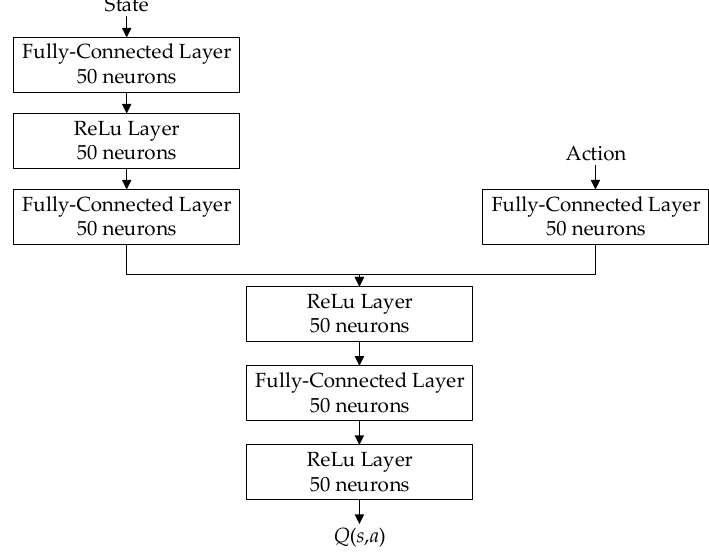
Figure 6. Diagram of the neural network used to approximate the action-value function by the critic of the DQN